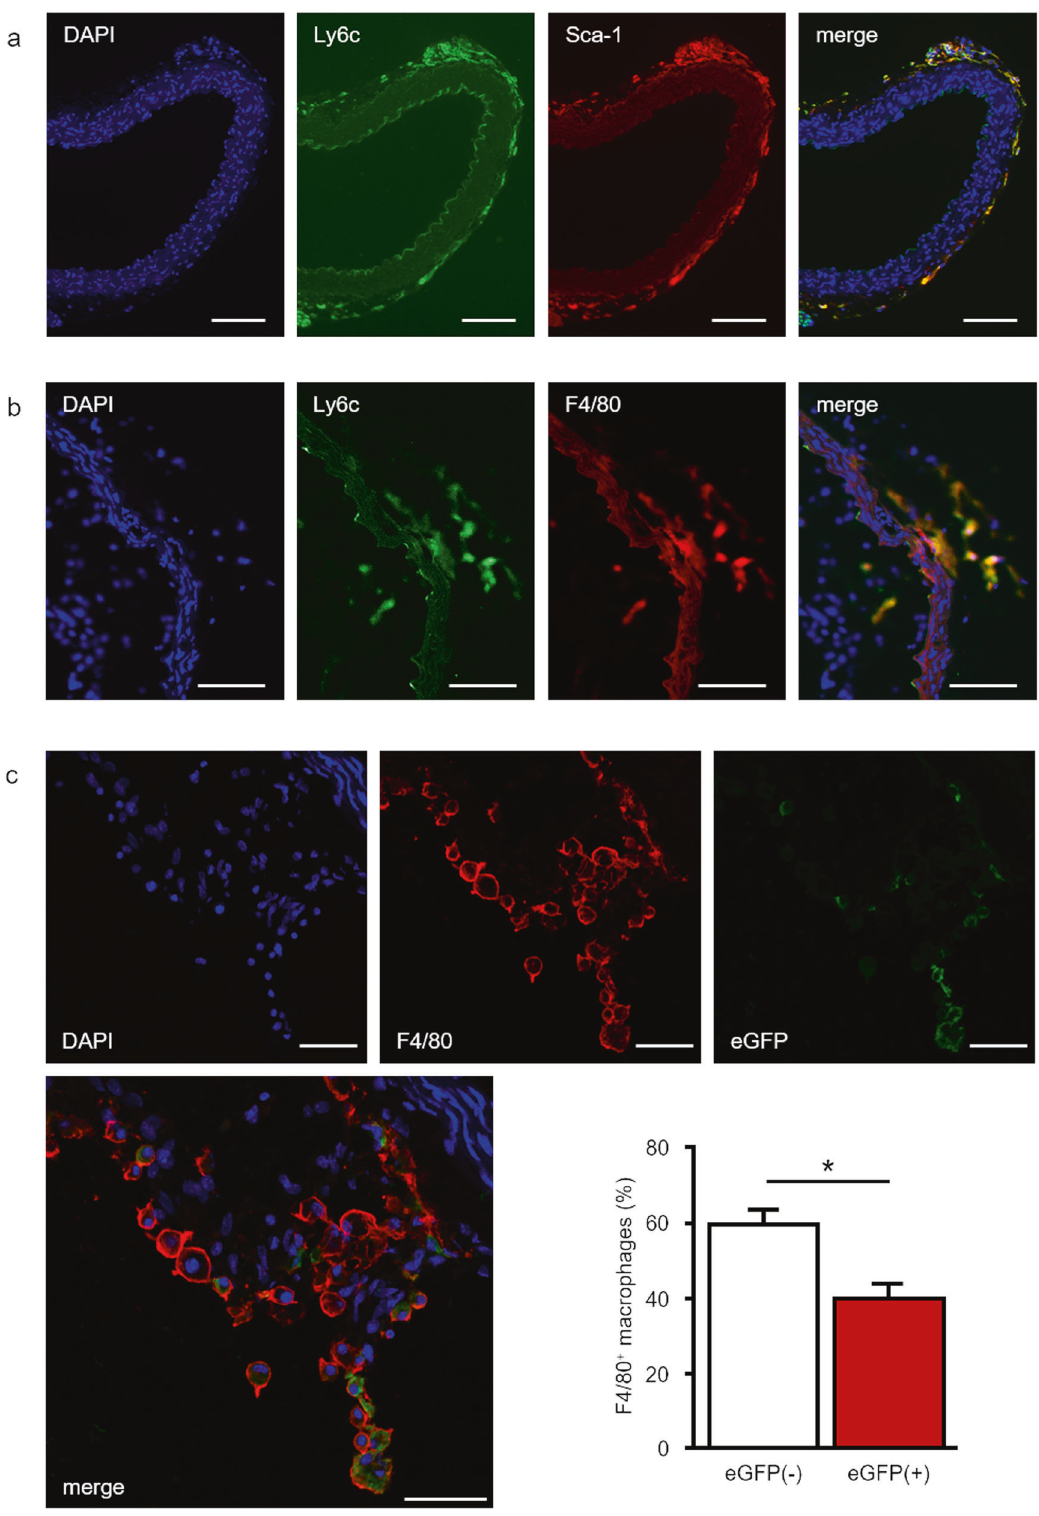
Fig. 2 The majority of macrophages in ARA originates from bone marrow-independent progenitors. a Cross-sections of freshly isolated murine aortae were analyzed by immuno fl uorescence for the presence of Ly6c + and Sca-1 + progenitor cells. Within the adventitia, a substantial part of Ly6c + cells co-expressed Sca-1 distinguishing them from Ly6c + monocytes that derived from the bone marrow and circulate in peripheral blood. b After ARA, cross-sections of murine aortae were analyzed by immuno fl uorescence for the presence of Ly6c + /F4/80 + cells. The majority of F4/80 + macrophages also expressed Ly6c suggesting their derivation from Ly6c + progenitor cells. c Confocal image of a cross-section of a cultured aortic ring from the FlkSwitch mouse. These sections were screened for F4/80 + cells (red immuno fl uorescence) and eGFP + cells (bone marrow-derived). Quantitative analysis of these sections ( n = 6) con fi rmed that 40% of F4/80 macrophages originate from bone marrow-derived cells (F4/80 + /eGFP + ) whereas 60% are generated from bone marrow-independent progenitors (F4/80 + /GFP - ). Scale bars: in a , b 100µm, in c 50µm. Cell Death and Disease (2022)